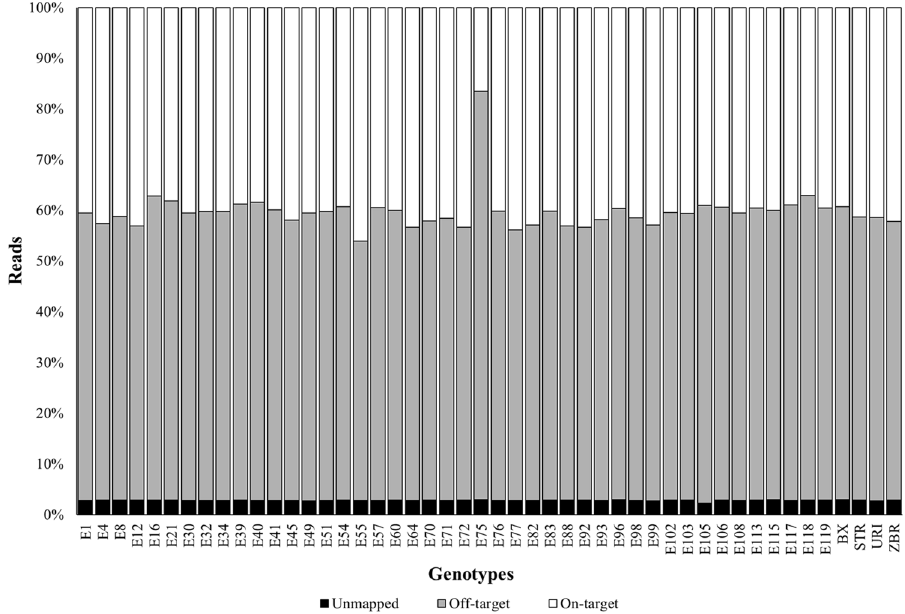
Figure 1. Bowtie2 alignment statistics. Pre-processed reads from the sequencing of 48 tomato genotypes were mapped along the tomato reference genome SL2.40.